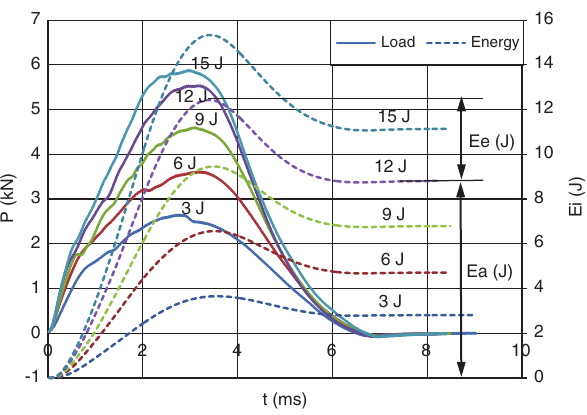
Figure 6 Variations of load and energy curves versus contact time for 12